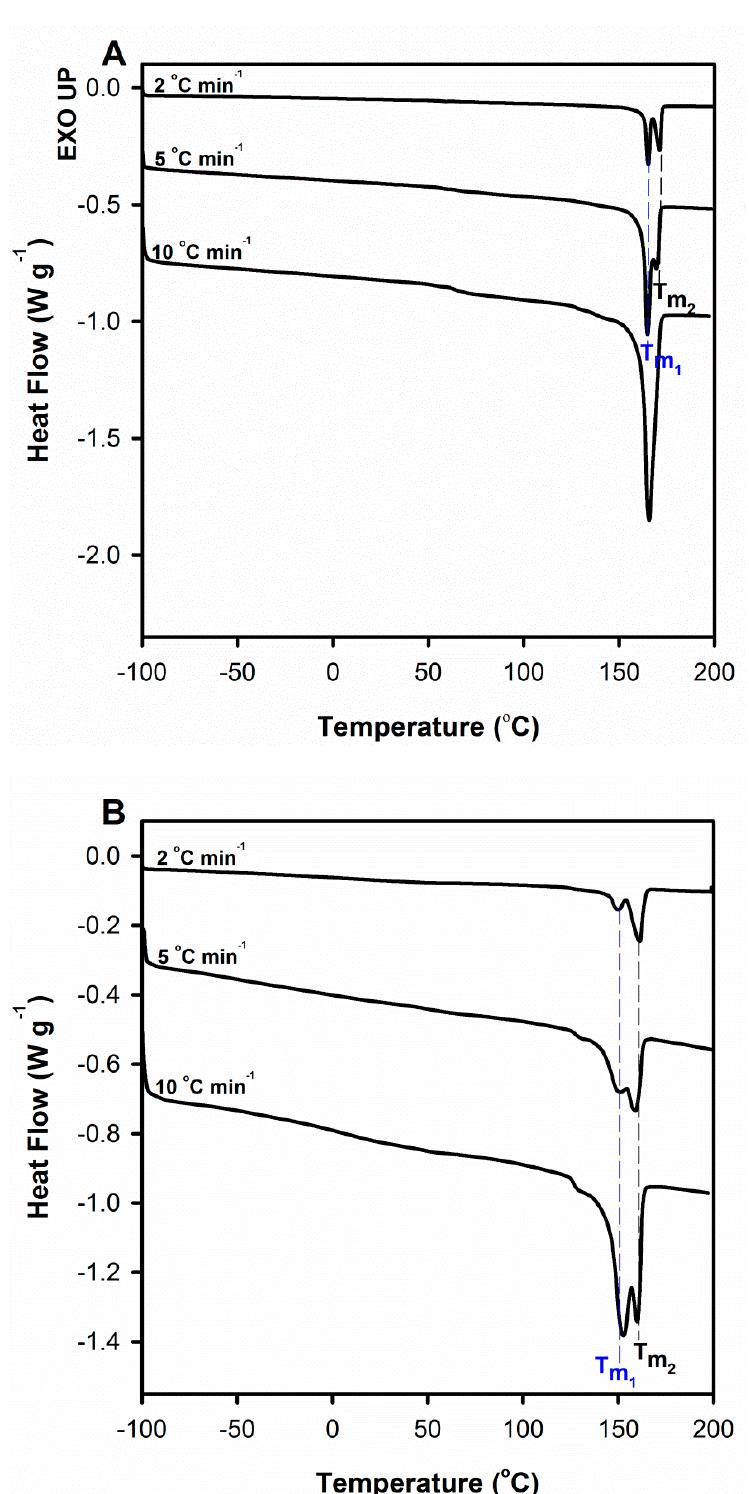
Figure 10. DSC melting thermograms of neat PLA ( A ) and PLA plasticized with TEC ( B ) at different scan rates. Thermograms have been shifted along the vertical axis for better visualization.